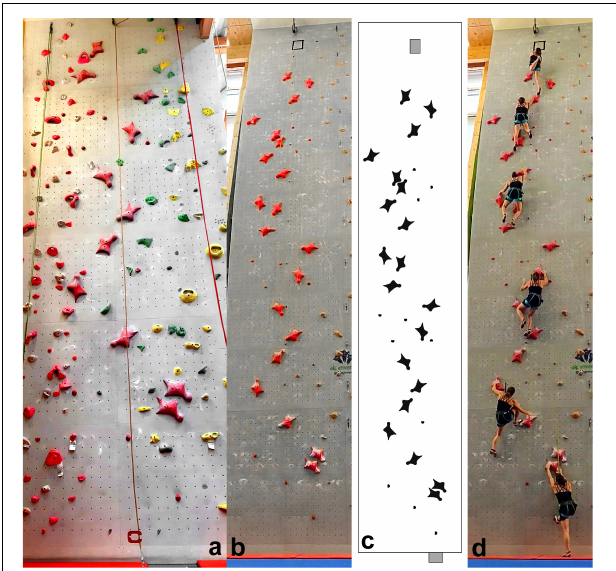
FIGURE 1 | Climbing walls used in this study; (a) 10-m walls; (b) 15-m walls; (c) hand- and foothold pattern of the 15-m wall according to the IFSC (International Federation of Sports Climbing [IFSC], 2014), and (d) participant climbing the 15-m wall.